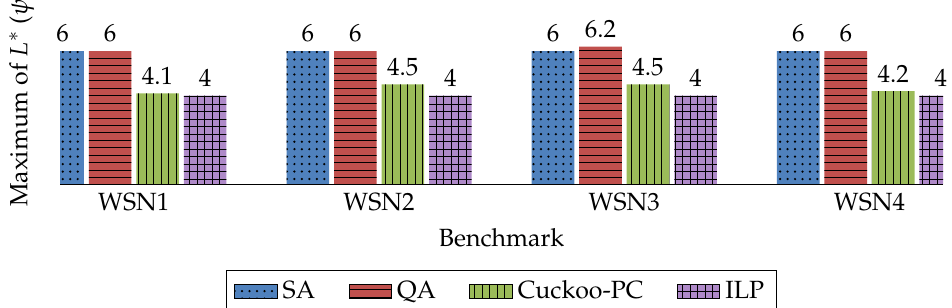
Figure 3. The maximum amount of L ∗ between all nodes ( ψ ) . (The average value over 30 runs of the algorithms).